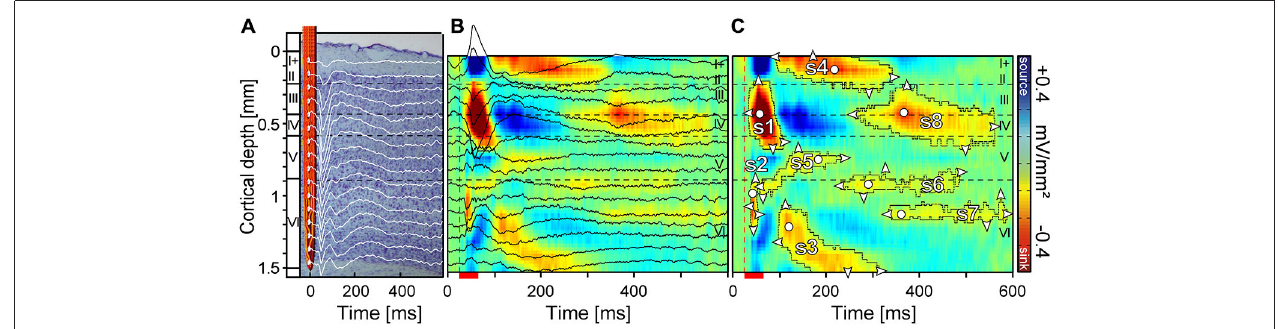
FIGURE 1 | Laminar local field potentials (LFP) and current source density (CSD) profile of a primary auditory cortex site tuned to 5.7 kHz. (A) Field potentials were recorded with a linear-array multicontact electrode covering all six cortical layers. Recordings were obtained simultaneously at each depth at an interchannel distance of 100 µ m. (B) CSD profiles were calculated from field potentials with color indicating current strength and direction. Current sinks (red) are classically interpreted as net inward transmembrane currents and current sources (blue) are net outward currents. (C) For the quantification of sinks, several contour lines were plotted using a criterion of 8% of the maximum sink strength. Eight sinks (s1–s8) could be defined within a time window of 600 ms. White circles represent the location of the maximum strength and white triangles the horizontal and vertical dimensions. Horizontal dashed lines indicate layer borders while the vertical dashed line marks the beginning of pure tone stimulation. Red scale bar represents pure tone stimulus duration of 30 ms.